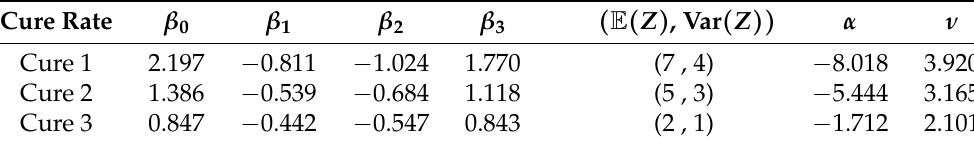
Table 2. True values of the parameters in the simulation